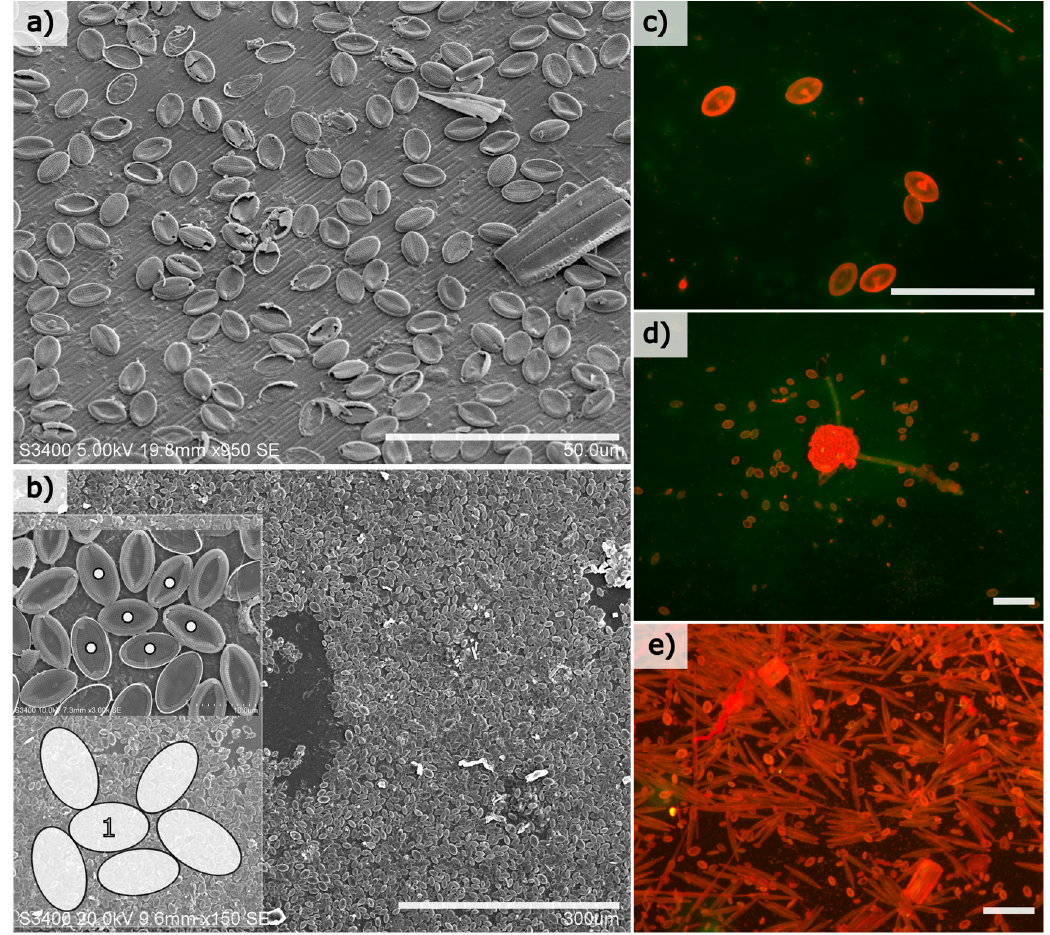
Figure 1. Representative scanning electron micrographs of elliptically shaped diatom frustules of various adnate diatom species (largely of the genus Cocconeis ) attached to a natural surface such as the textured periostracum of Mytilus edulis ( a ) and smooth (at the macroscale) glass substrate ( b ) (scale bars = 50 and 300 µm, respectively). An example of the packing density of individual diatom cells is shown in the inset of ( b ), where individual cells are labelled with dots, and how individual cells can become “jammed” between surrounding cells at high abundance on a surface is illustrated in the cartoon inset, where the cell labelled “1” is prevented from rotating or moving by the surrounding cells. Epifluorescence images ( c – e ) show how cells initially colonise and distribute on a glass surface at low abundance after approximately 5–10 days immersion ( c ), until cells begin to proliferate on surfaces after approximately 14 days ( d ) until eventually forming the understory of an established and diverse diatom biofilm after 1 month ( e ) (each scale bar = 100 µm). Note that many of the other cell types in ( e ) are loosely attached to the glass surface and often have attachment strategies that differ from the adnate, near-elliptical-shaped cells that closely attach to the substrate.